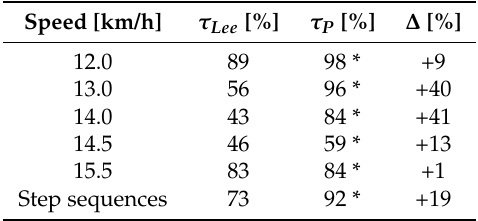
Table 8. Results of fuzzy classification on steps and step sequences, using the percentage of acceptable classification τ parameter for the two approaches: Lee’s (Lee) and proposed (P). The best value of τ for each speed are highlighted with *. ∆ represents the difference between τ P and τ Lee